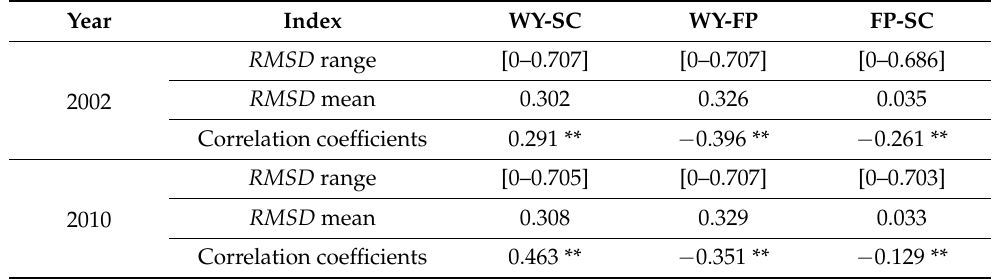
Table 2. Correlation coefficients between ES pairs in the BLJW in Gansu from 2002 to